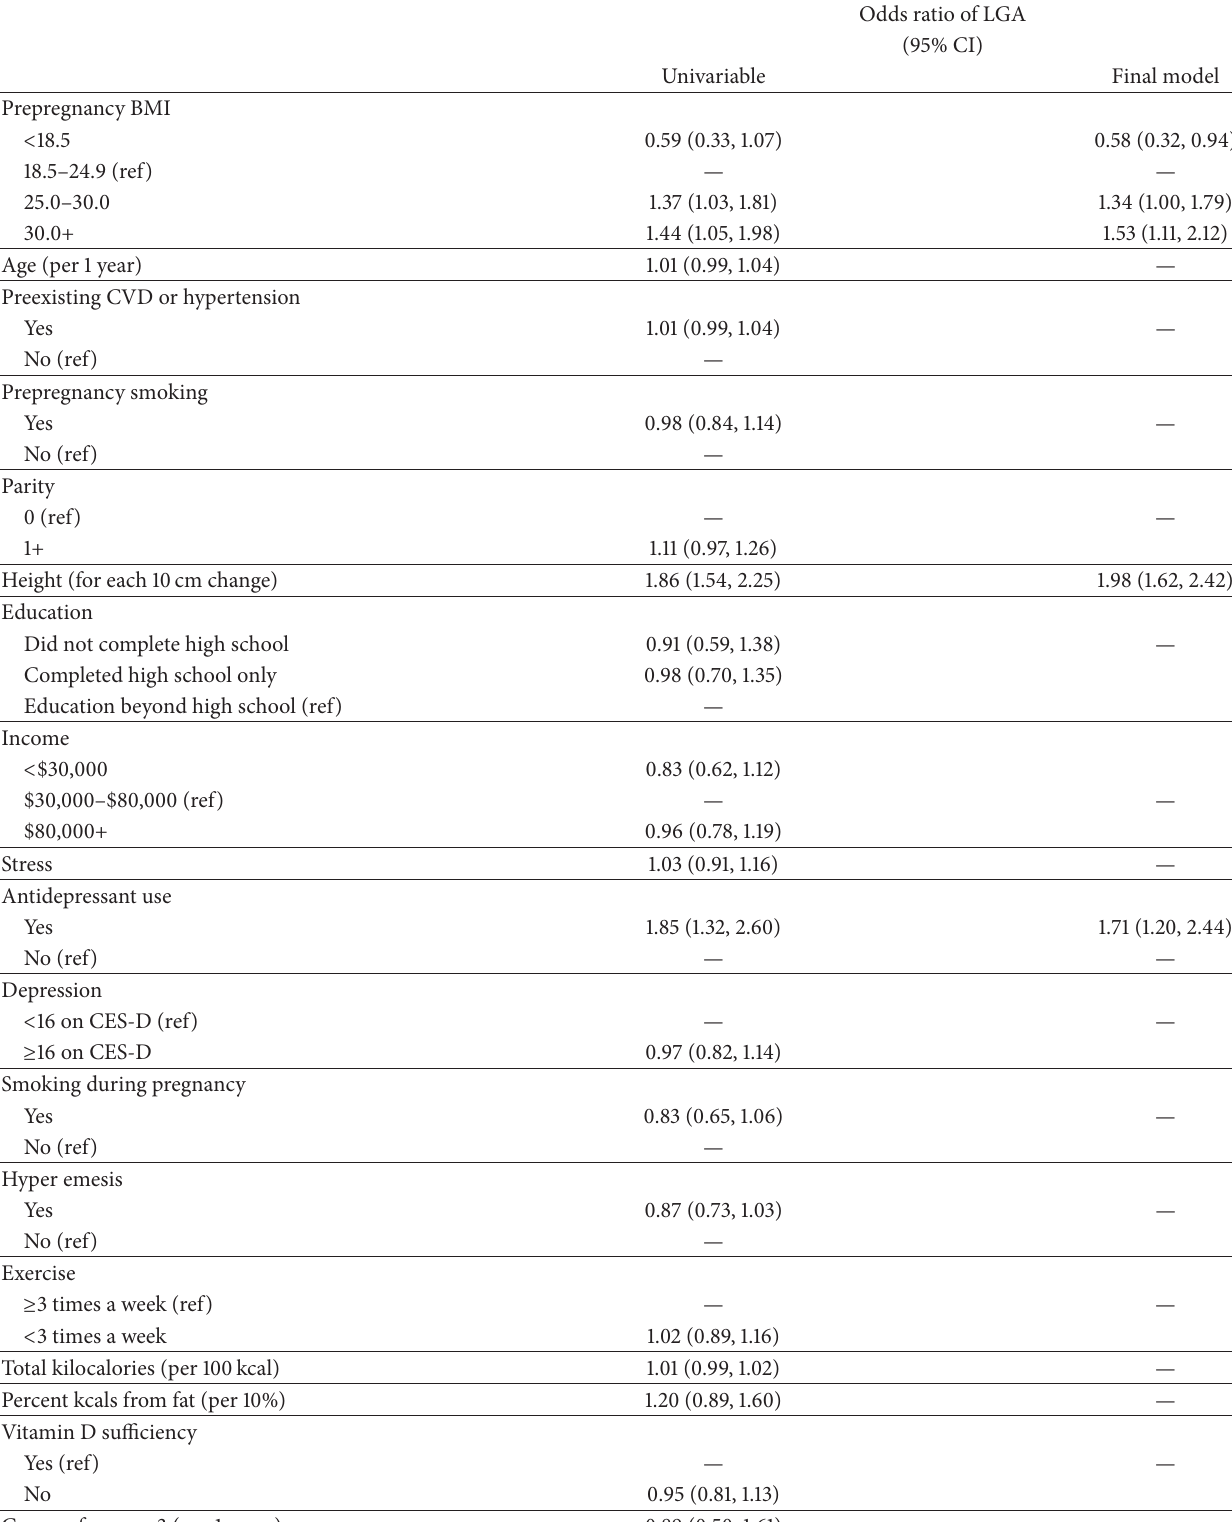
Table 2: Determinants of size for gestational age